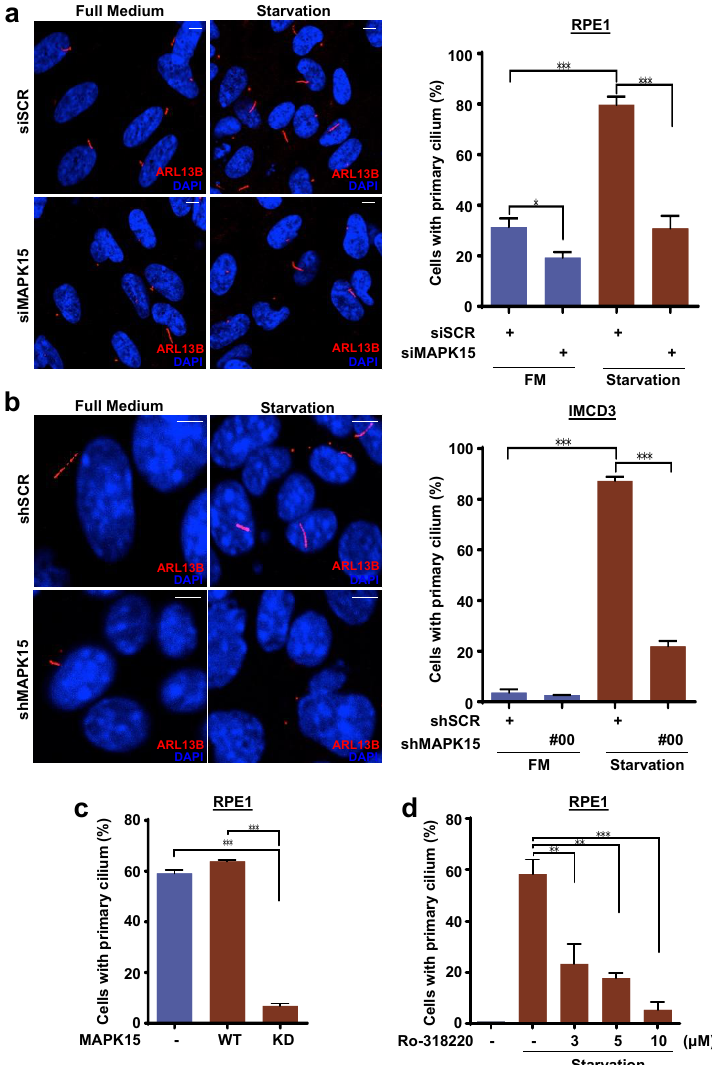
Figure 1. MAPK15 controls primary ciliogenesis in a kinase-dependent fashion. ( a ) RPE1 cells were transfected with scrambled siRNA (siSCR, negative control) or MAPK15 siRNA (siMAPK15) and, after 24 h, incubated in full medium (FM) or starvation media (starvation) for an additional 48 h. Cells were next fixed and subjected to immunofluorescence analysis. In these representative images, ARL13B is visualized in red and nuclei in blue (DAPI). Scale bars correspond to 25 μm. Percentage of primary cilium-positive cells was plotted on the accompanying graph (right panel). ( b ) IMCD3 cells, stably expressing scrambled (shSCR) or MAPK15 (shMAPK15)-specific shRNAs were incubated in full medium (FM) or starvation media for an additional 24 h. Cells were next fixed and subjected to immunofluorescence analysis. In these representative images, ARL13B is visualized in r ed and nuclei in blue (DAPI). Scale bars correspond to 25 μm. Percentage of primary cilium-positive cell was plotted on the accompanying graph (right panel). ( c ) RPE1 cells were transfected with empty vector (Ctrl), MAPK15_WT, or MAPK15_KD, and, after 24 h, incubated in starvation media for an additional 24 h. Cells were next fixed and subjected to immunofluores- cence analysis to score the number of cilium-positive cells. Percentage of primary cilium-positive cell was plotted on the graph. ( d ) RPE1 cells were incubated in starvation media and treated with indicated amounts of the Ro-318220 MAPK15 inhibitor for 24 h. Cells were next fixed and sub- jected to immunofluorescence analysis to score the number of cilium-positive cells. Percentage of